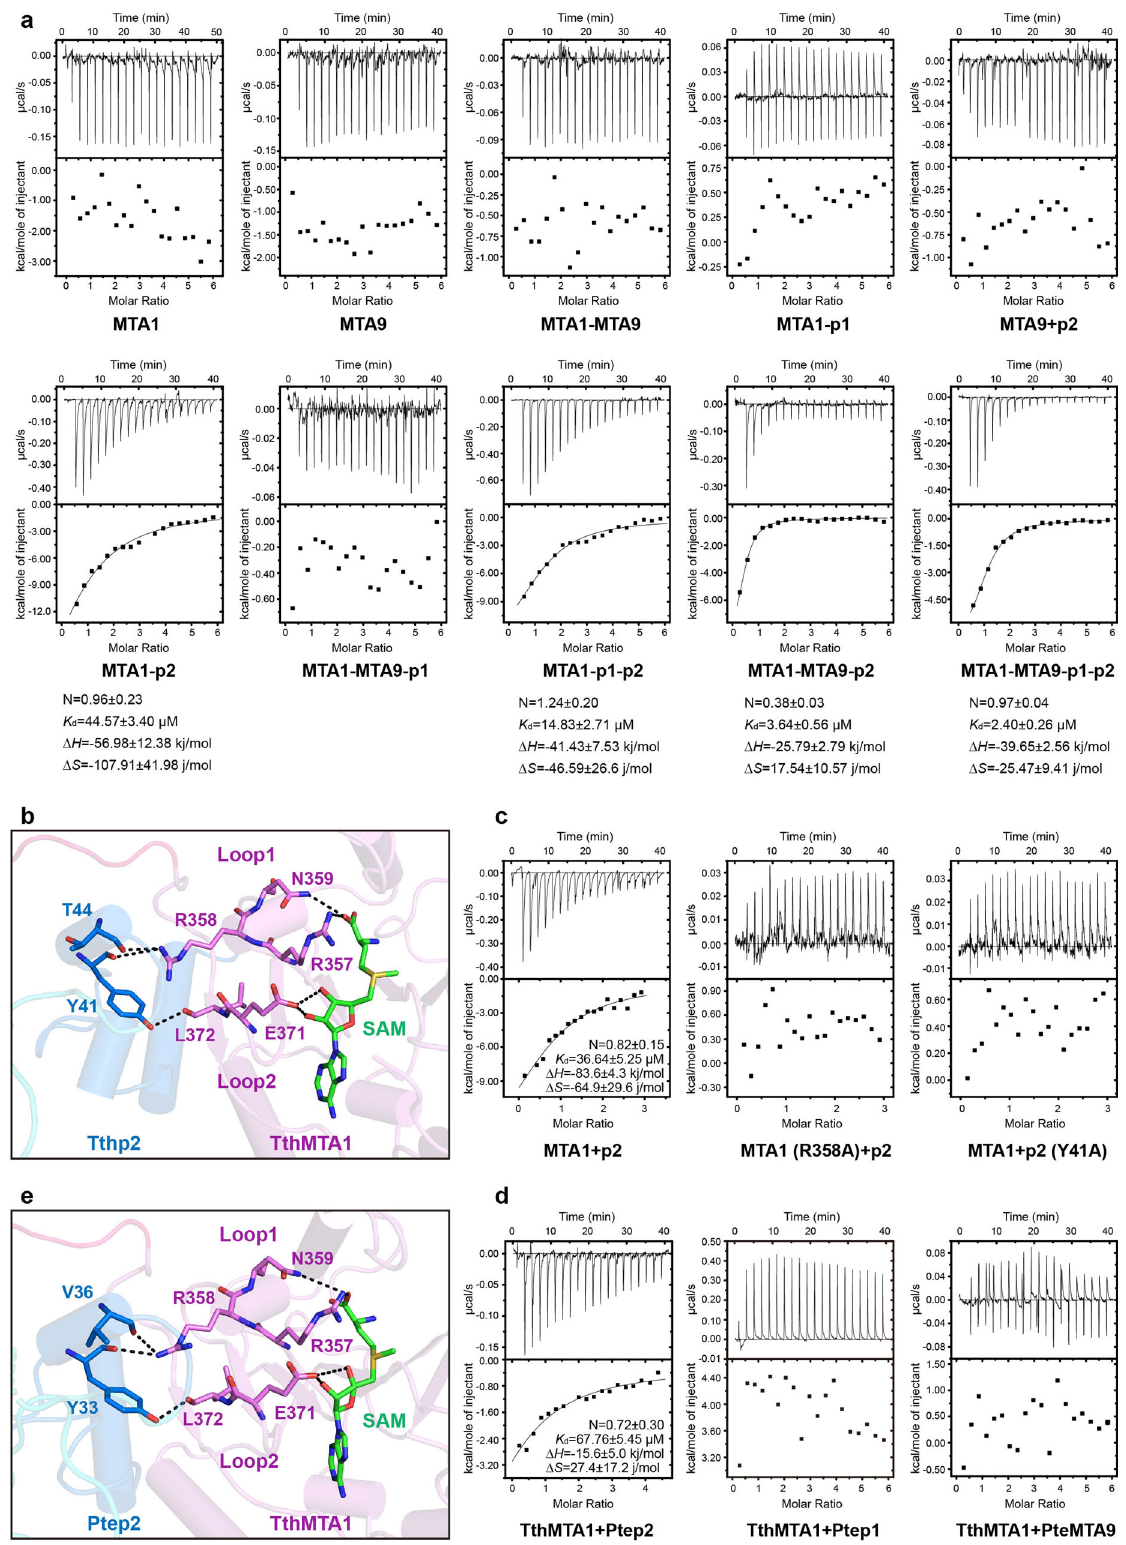
Fig. 5 p2 induced the activation of MTA1. a ITC assay using single TthMTA1, TthMTA9, as well as two-component, three-component, and four- component TthMTA1c complexes. b Detailed interactions between the SAM-binding loops of TthMTA1 and the NTD domain of Tthp2. c ITC assay measuring the SAM-binding af fi nity of wild-type or mutant TthMTA1 in the presence of wild-type or mutant Tthp2. d ITC assay measuring the SAM- binding af fi nity of TthMTA1 in the presence of Ptep2, Ptep1 or PteMTA9. e Detailed interactions between the SAM-binding loops of TthMTA1 and the NTD domain of